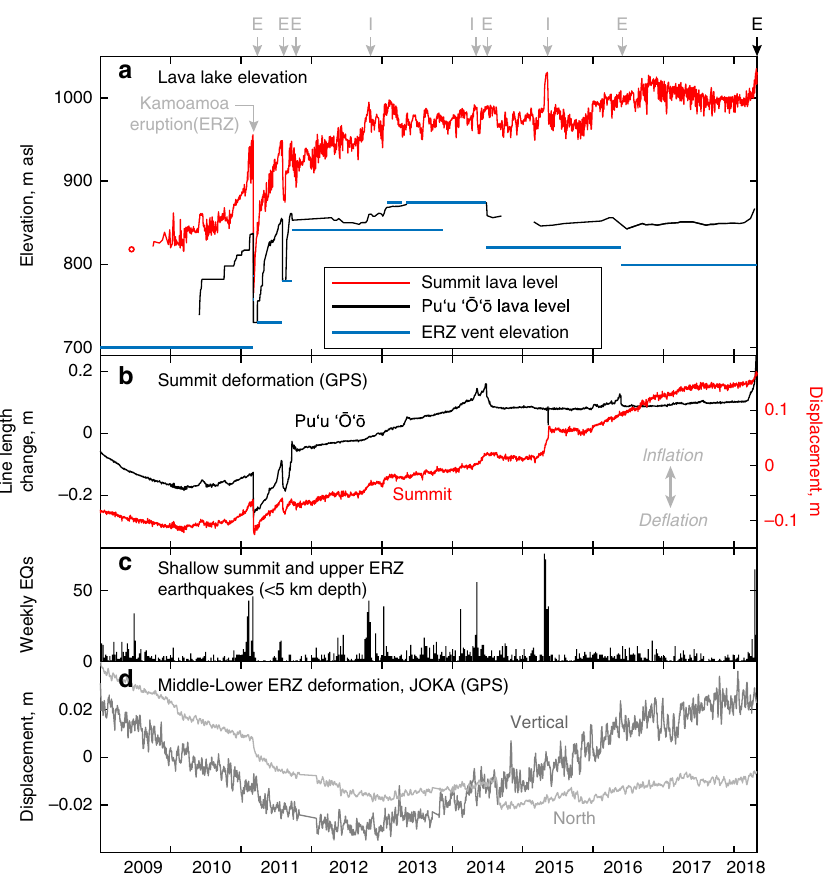
Fig. 3 Long-term changes on K ī lauea, 2009 – 2018. a Elevation of the lava lakes at the summit and Pu ʻ u ʻ Ō ʻ ō , as well as the elevation of the vents at or near Pu ʻ u ʻ Ō ʻ ō . “ E ” notes times of eruptive vents forming on the East Rift Zone (ERZ) (at or near Pu ʻ u ʻ Ō ʻ ō ), and “ I ” notes the time of intrusions at the summit — most eruptions and intrusions were preceded by rapid summit in fl ation and lava lake rise and an increase in shallow summit and upper ERZ earthquakes. The Kamoamoa eruption is noted speci fi cally due to the broadly similar precursors it shared with the 2018 eruption. b Northward displacement of summit GPS station UWEV, and line-length change between Pu ʻ u ʻ Ō ʻ ō stations PUOC and JCUZ, showing a long-term in fl ationary trend at both eruption sites. c Shallow (<5 km depth) summit and upper ERZ earthquakes (magnitude 1.7 and greater), which often increase in rate during summit pressurization. d Displacement of GPS station JOKA, in the middle-lower ERZ, showing the onset of uplift in early